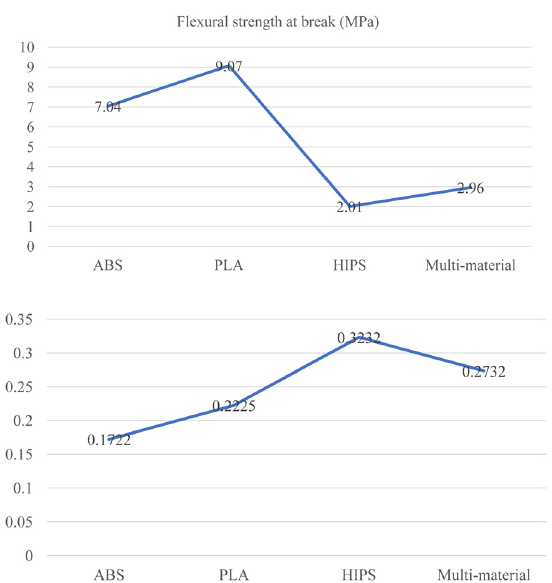
Figure 19. Predicted set of input process variable for production